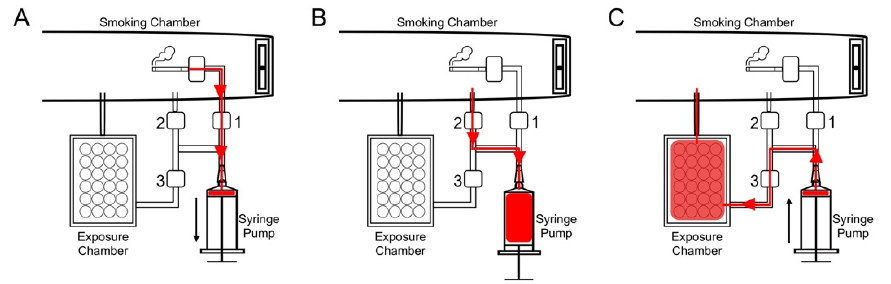
Figure 2. Schematic process of the dilution. ( A ) Open smoke valve (1) to generate puff. ( B ) Open air valve (2) to draw in air to dilute the smoke. For higher dilutions, part of the smoke—air mixture was pushed out of the air valve (2) and additional air was drawn in via the air valve (2). ( C ) Open exposure valve (3) to direct the smoke–air mixture into the exposure chamber and onto the cells. At the end of the cycle, an additional push with fresh air was used to remove the smoke out into the smoking